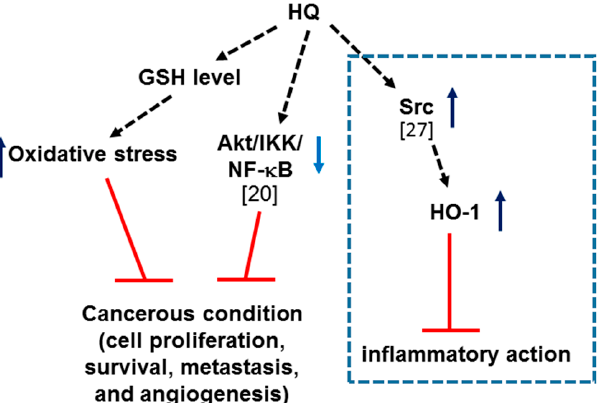
Figure 7. Putative inhibitory pathway of HQ-mediated anti-cancer activity. ↑ (ateneo blue): stimulation; ↓ (blue): inhibition; T (red): suppression of target biological responses.